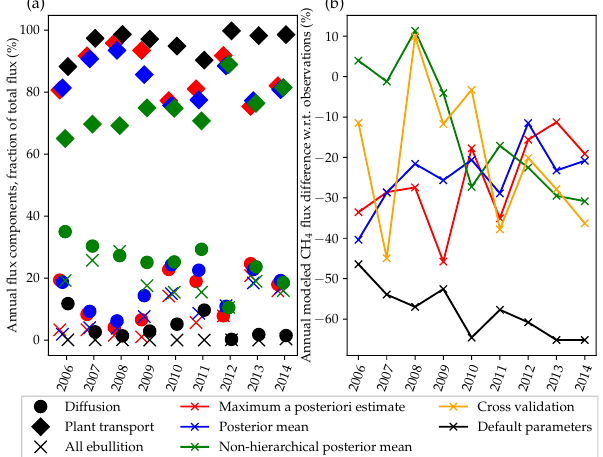
Figure 7. (a) Proportions of flux components as a function of the year. Diamonds are for plant transport, balls for the diffusion flux, and crosses describe the total ebullition taking place. The figure on the right shows the annual model–observation mismatch in per- cent for the methane flux, where only residuals from days with ob- servation data available have been taken into account. The data in panel (a) have been spread slightly for readability in the x -axis di- rection. The orange line in panel (b) represents the results from the cross validation discussed in Sect. 5.6. Note that the optimization target was not to directly fit annual